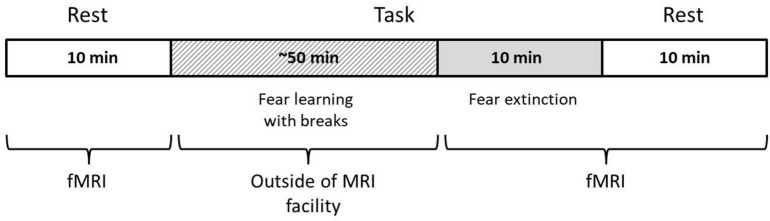
Scheme of the experimental paradigm.